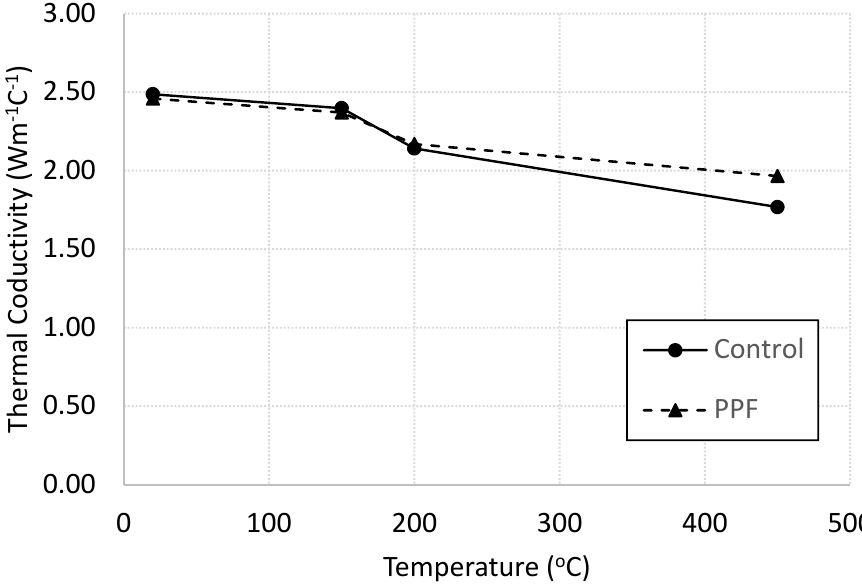
Figure 9. Thermal conductivity of control and fiber-reinforced specimens heated at various levels.